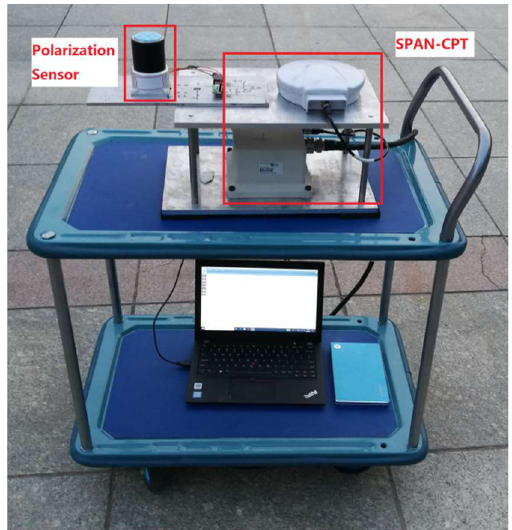
Figure 26. Photograph of dynamic outdoor setup.